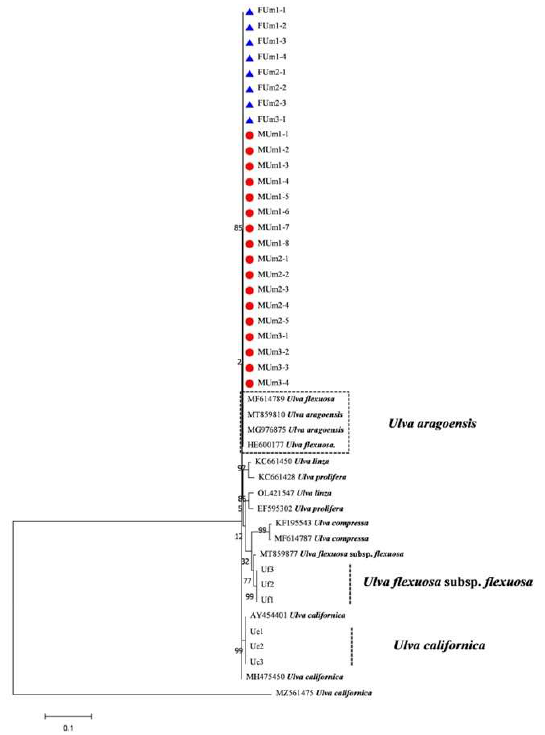
Figure 7. Maximum likelihood tree constructed from the analysis of tuf A gene sequences of U. aragoensis samples and those downloaded from GenBank.